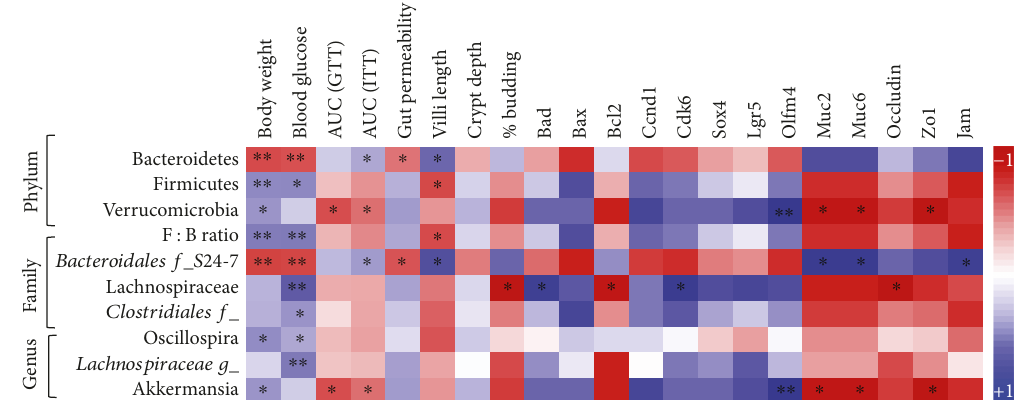
Figure 4: Relationship of metabolic functions, intestinal morphology, and functions with gut microbiome dysbiosis, independent of dietary di ff erences. Spearman correlation analysis to establish the association between metabolic measures (body weight, blood glucose, AUC-GTT, and AUC-ITT), gut permeability changes, intestinal structural changes, and gene expression changes and the gut microbiome signature between Lep ob/ob and B6 mice. Values presented here are average of 3 – 8 replicates. p values are de fi ned as ∗ < 0 05 and ∗∗ < 0 01